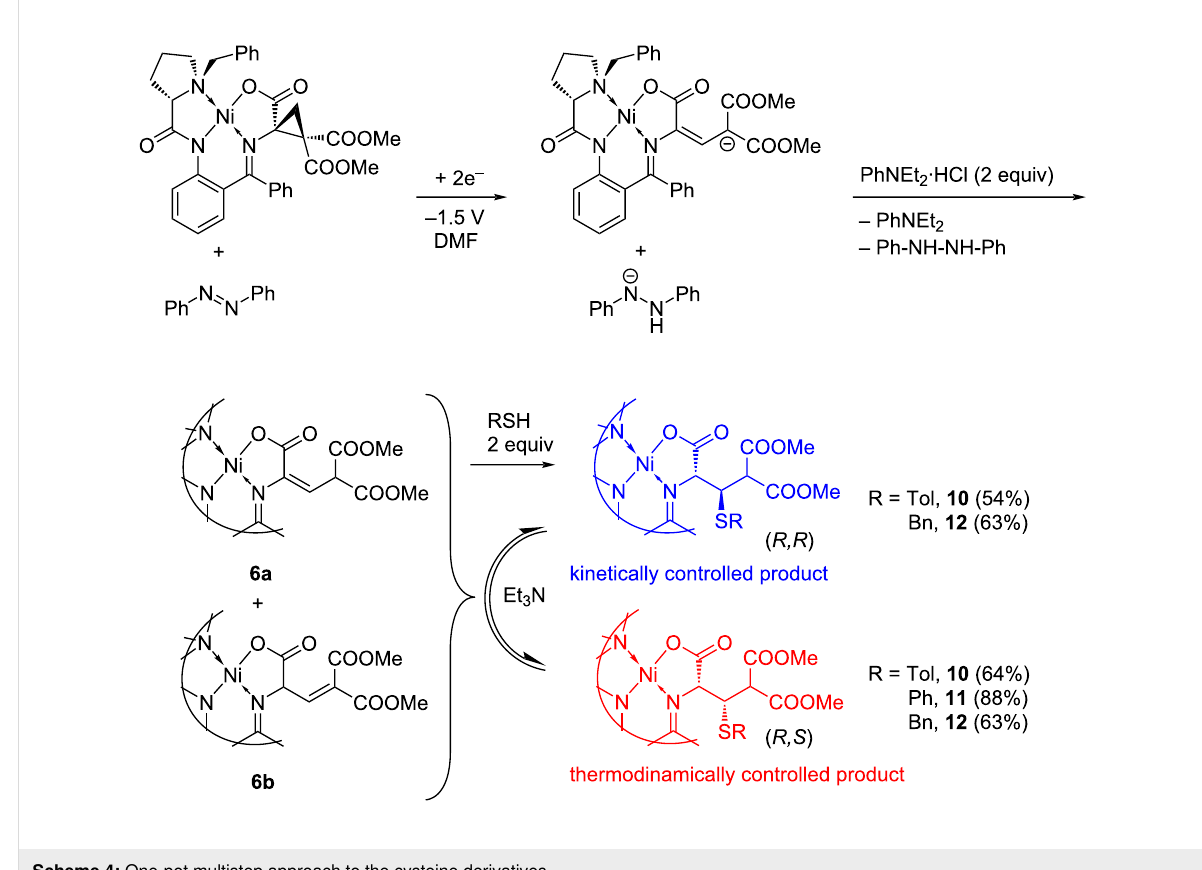
Scheme 4: One-pot multistep approach to the cysteine derivatives.